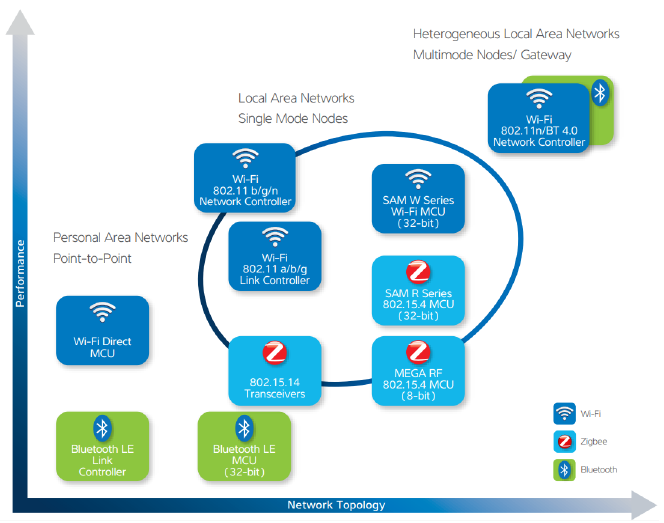
Figure 4. Networking capabilities.